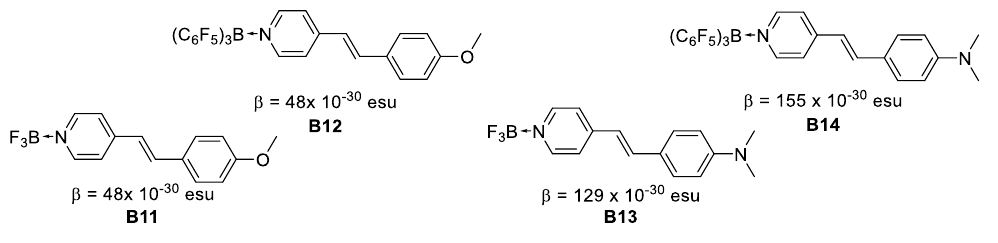
Figure 13. Binding Lewis-acidic boranes to stilbazoles.